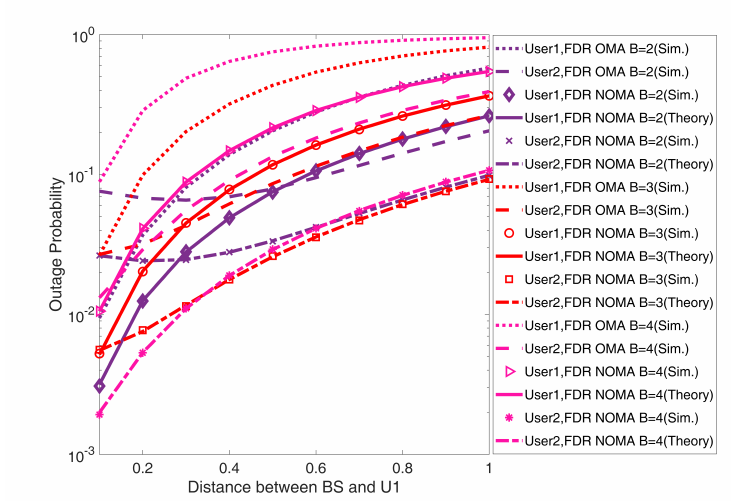
Figure 8. Outage probability versus distance of U 1 i.e., UAV from BS for U 1 and U 2 in UAV-FDR based-NOMA and OMA schemes ( E ( | h LI | 2 ) = − 15 dB ).